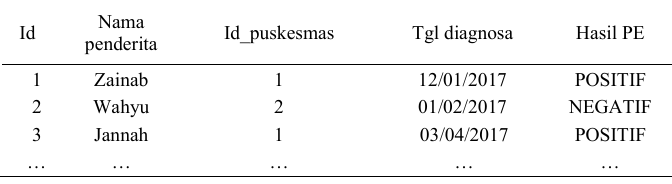
TABLE 1 RECAP OF DBD PATIENTS REGISTER